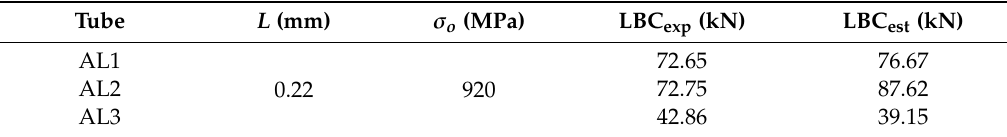
Table 5. Values of L and σ o obtained from calibration, together with the experimental and the estimated values of load-bearing capacity (LBC).